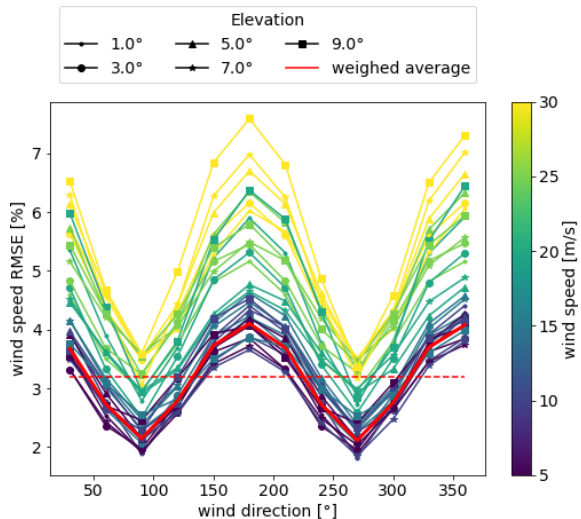
Figure A1. RMSE of simulated VAD. The resulting RMSE is cal- culated for 100 runs of each combination of parameters as shown in Table A2. Lines in red represent values weighed with the frequency distribution of wind speed and wind direction at the site. The dashed line represents the average of the continuous red